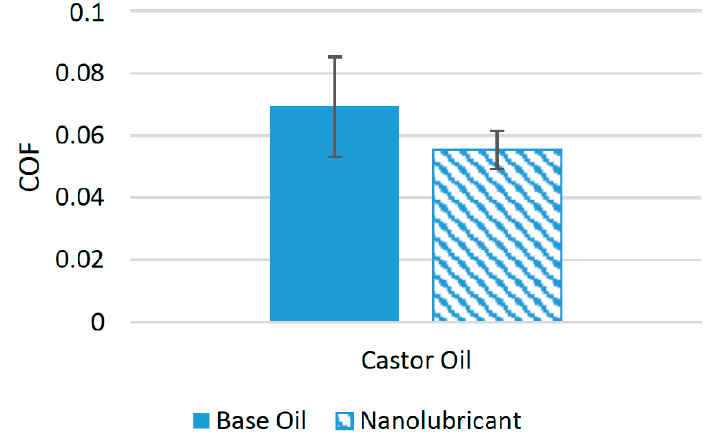
Figure 16. Effect of h-BN NPs on the friction performance of bio-lubricants.